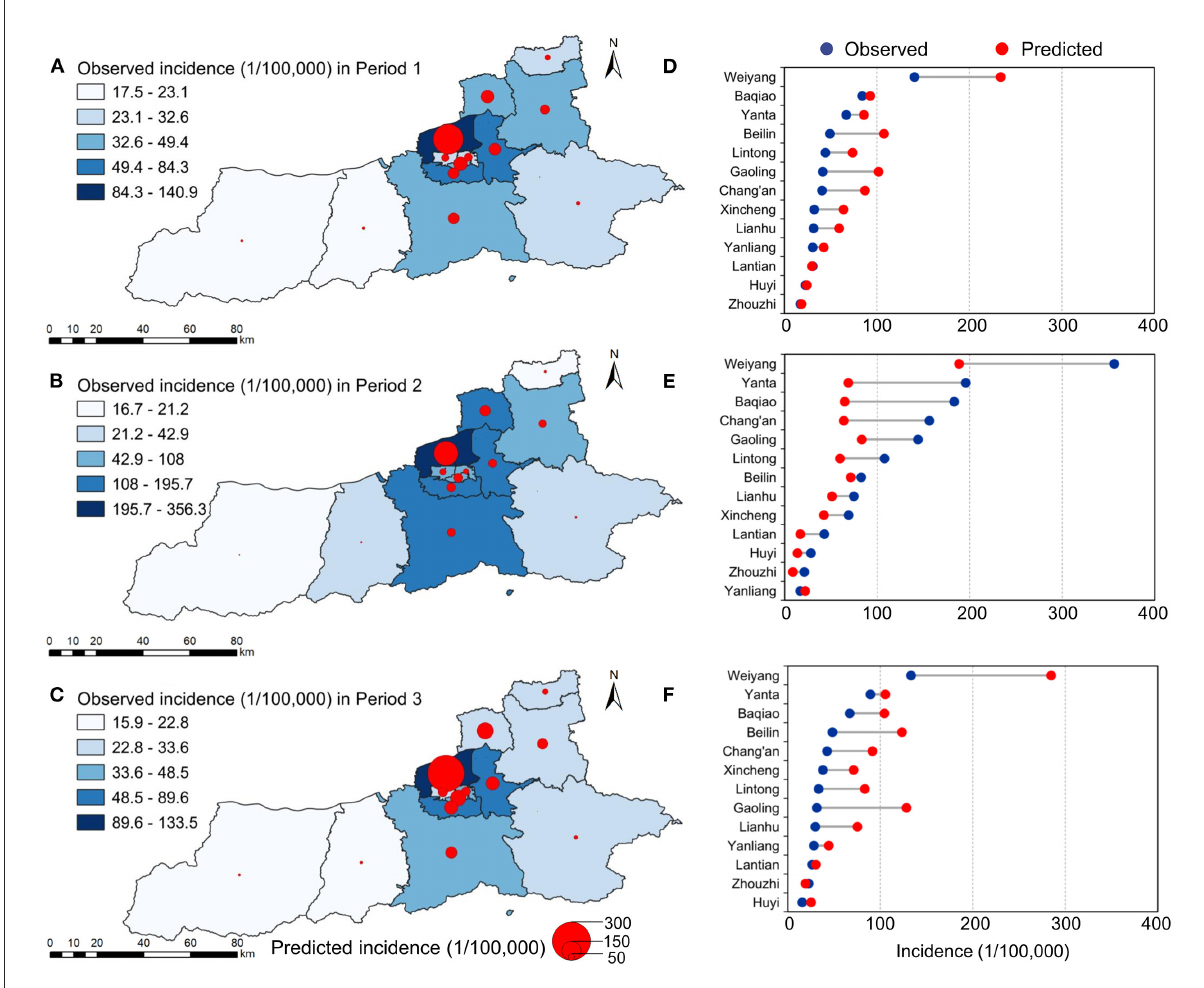
FIGURE4 Observed incidence and predicted incidence maps of infectious diarrhea at county level in Xi’an during P1, P2, and P3 (A–C) and county-level differences between predicted and observed values during the different periods (D–F)